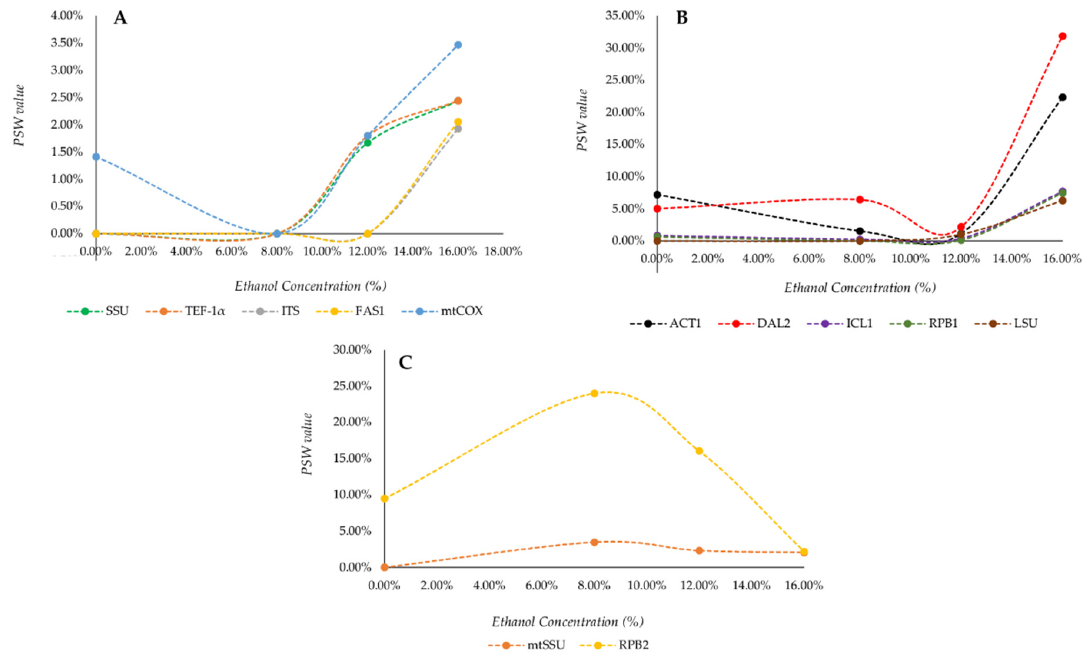
Figure 3. Trends of significative correlations between taxonomic markers and whole FTIR spectra from cells under short-term ethanol stress. Correlations between the distances of the IR spectra from cells challenged with four different ethanol concentrations (0%, 8%, 12% and 16%) and those obtained considering each taxonomic marker under study were reported as trends of Percentages of Significative Wavelengths (PSW). Markers were grouped according to their correlation trend in: low intensity responses ( A ); high intensity responses ( B ); and non-monotonous responses ( C ).